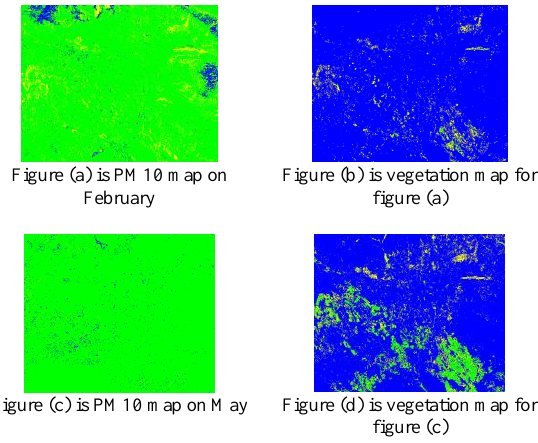
Figure 4. The relationship between vegetation and air pollution